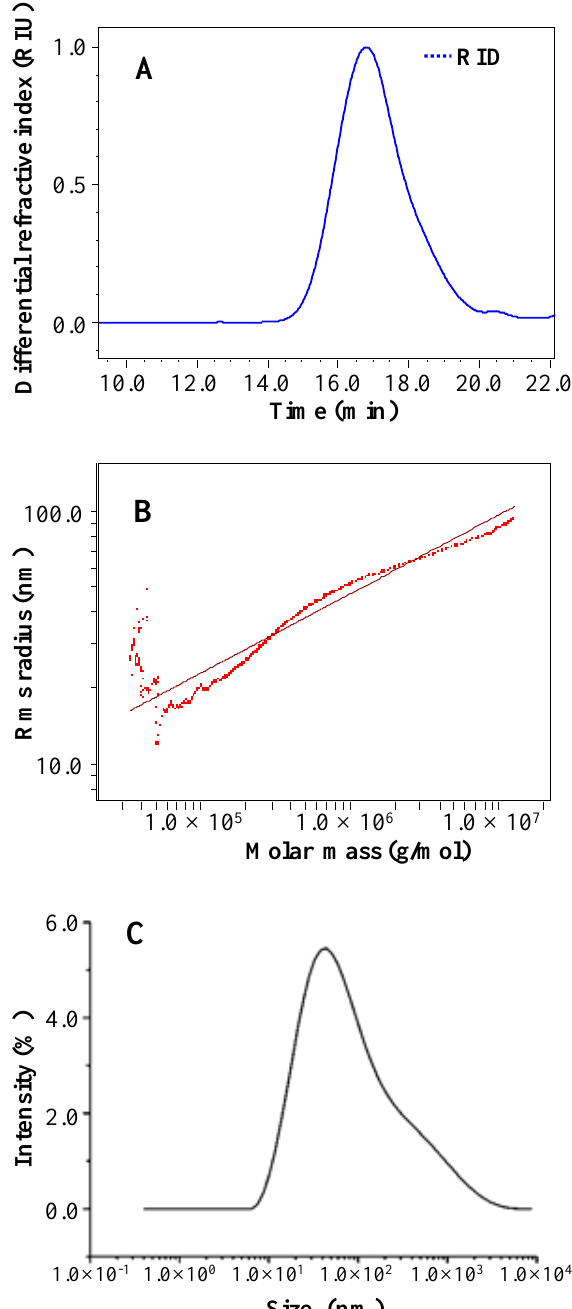
Figure 4. High-performance size-exclusion chromatogram ( A ), dependence of radius of gyration on molar mass ( B ), and hydrodynamic radius ( C ) of OPP-D.